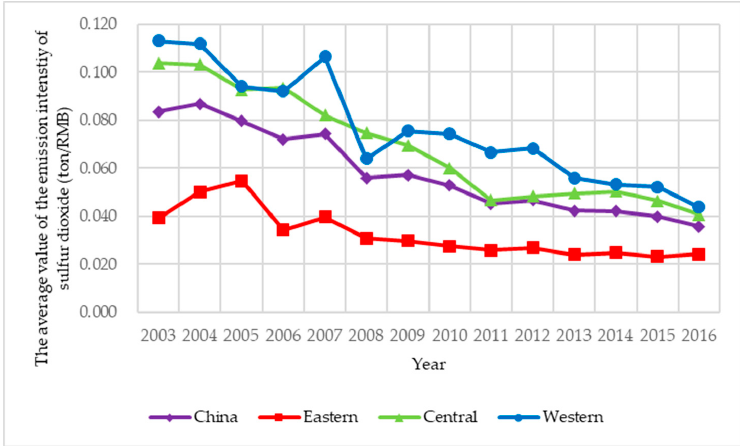
Figure 3. The average value of the emission intensity of sulfur dioxide in China during 2003–2016.